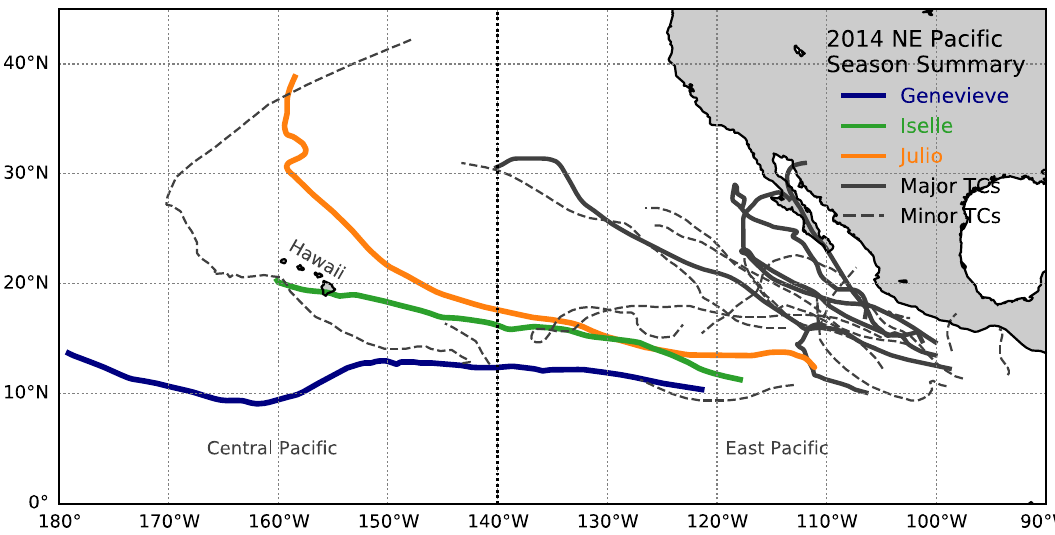
Figure 1. Tropical cyclone (TC) tracks of the 2014 Northeast Pacific hurricane season. Minor TCs (defined as Category 2 status and below) are noted by thin grey dashed line, while major TCs (Category 3 status and above) are in thick grey. TCs of particular interest to our study are highlighted in color—Hurricane Genevieve in blue, Hurricane Iselle in green, and Hurricane Julio in orange. The boundary between the East and Central Pacific basins at 140° W is shown with a vertical gray line.